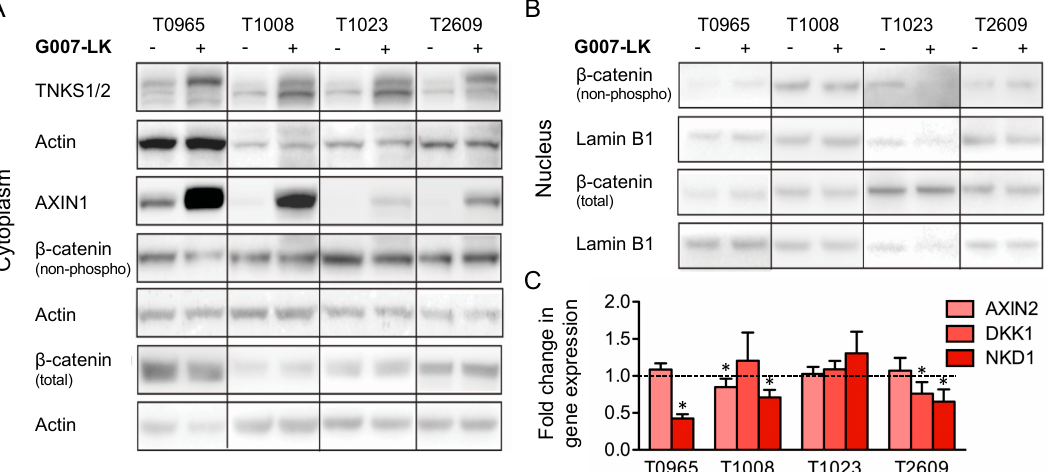
Figure 2. G007-LK stabilizes cytoplasmic AXIN1 and reduces the expression of WNT / β -catenin target genes. The effect of G007-LK treatment on the ( A ) cytoplasmic and ( B ) nuclear levels of WNT / β -catenin signaling proteins, as assessed by Western blotting; ( C ) Fold change in gene expression of WNT / β -catenin target genes, as assessed by qPCR upon treatment with G007-LK. For both analyses, GSC cultures were treated for 72 h with G007-LK (500 nM) or DMSO (0.01%). Values are relative to those of the DMSO control and are expressed as the fold changes from the DMSO control. DKK1 was not detectable in T0965 and is therefore not shown. The results are presented as the mean ± SD. * p <